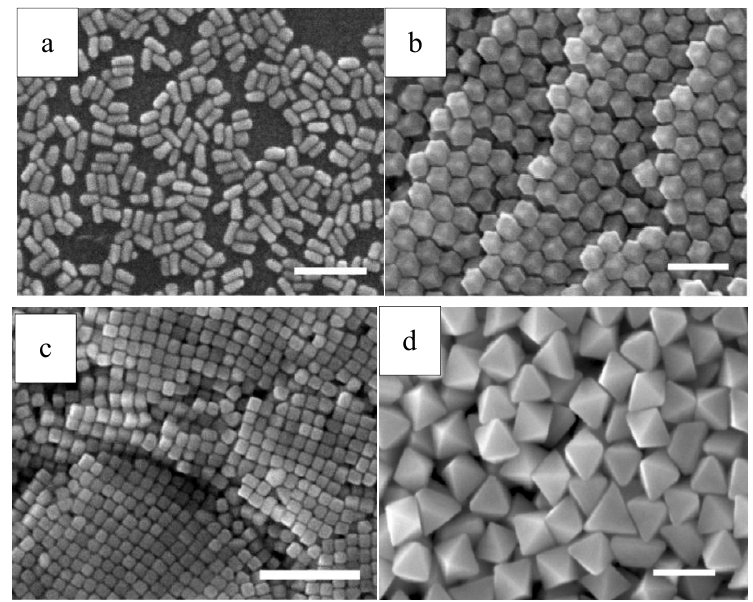
Figure 2. Single-crystalline Au nanocrystals with different shape ( a ). nanorods; ( b ). rhombic dodecahedra; ( c ). cubic nanocrystals; ( d ). octahedral nanocrystals). Reproduced with permission [51]. Copyright 2009, American Chemical Society.